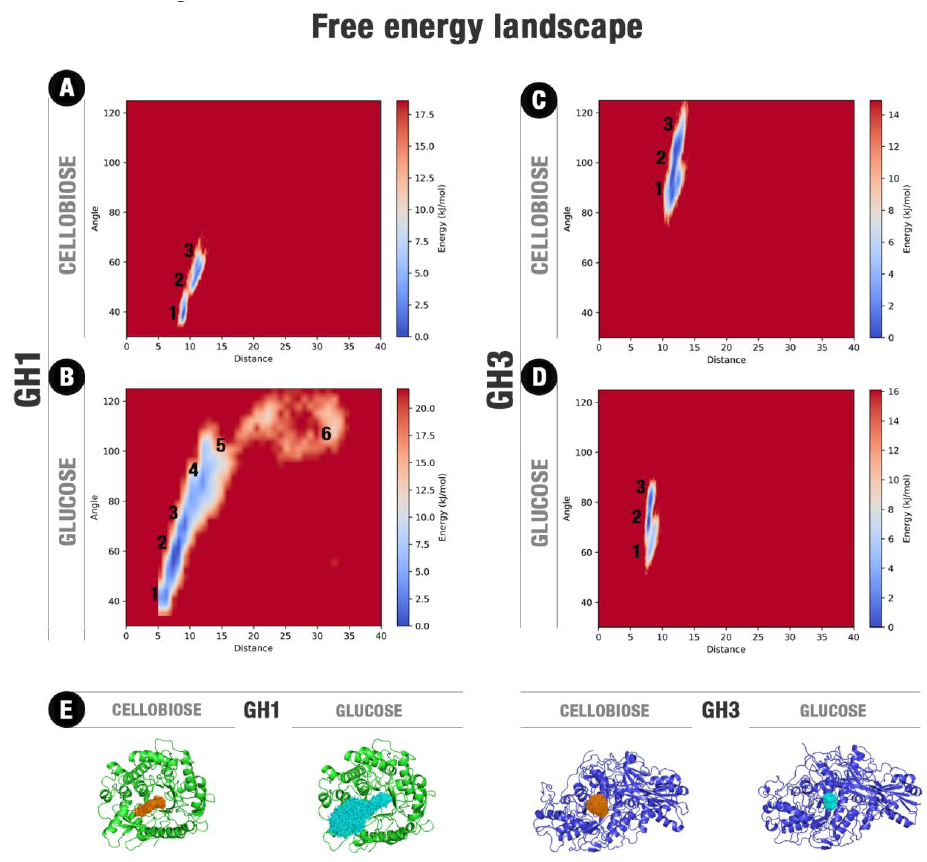
Figure 2. Free energy landscapes (FEL) for cellobiose and glucose at their respective and individual complexes with GH1 and GH3. ( A ) HiBG complexed with cellobiose, ( B ) HiBG complexed with glucose. This FEL was depicted considering together the respective GH1–glucose-1 and GH1-glucose-2 sets of simulations. The respective starting points at the simulations GH1–glucose-1 and GH1-glucose-2 are at the regions 3 and 1, ( C ) AaBG complexed with cellobiose, ( D ) AaBG complexed with glucose. The distance is relative to the geometric center of each ligand and the catalytic E378 (in GH1) or H121 (in GH3). The angle is formed by these two geometric centers and the geometric center of each protein. ( E ) Superposition of the ligand poses around all the respective trajectory ensembles for each system. Protein average frames are shown in green (HiBG) and blue (AaBG) cartoons. All frames of ligand positions for cellobiose (orange) and glucose (cyan) were overlapped.